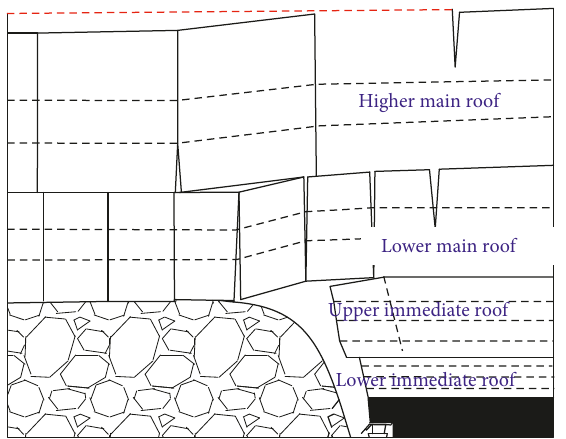
Figure 12: Overlying strata structure model.